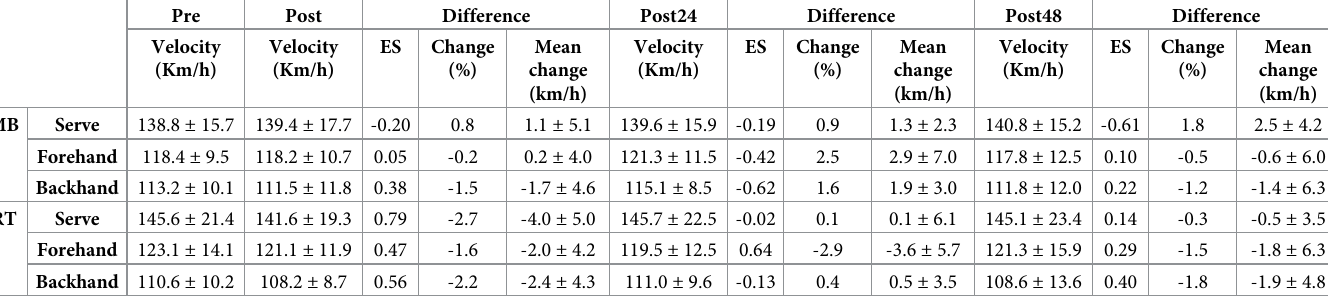
Table 3. Acute (Post) and delayed (Post24 and Post48) effects of medicine ball throws training (MB) and resistance training (RT) on ball velocity and correspond- ing percentage changes from baseline. Pre Post Difference Post24